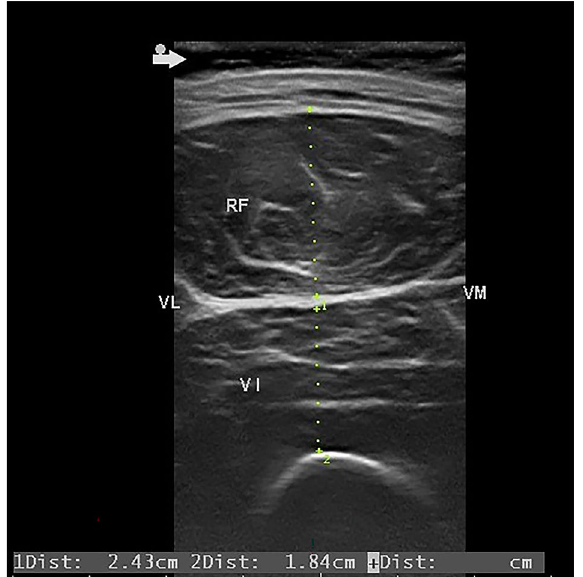
Figure 1. Ultrasound measurements RF: rectus femoris muscle, VI: vastus intermedius muscle, VL: vastus lateralis muscle, VM: vastus medialis muscle, Green dotted line 1: thickness of RF, Green dotted line 2: thickness of VI, Arrow: placement of the gel to ensure that there is no pressure on the muscles to produce deformation.